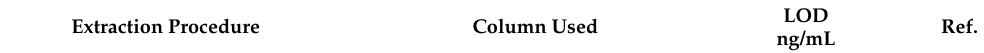
Table 4. Comparison between the current method and the previously published